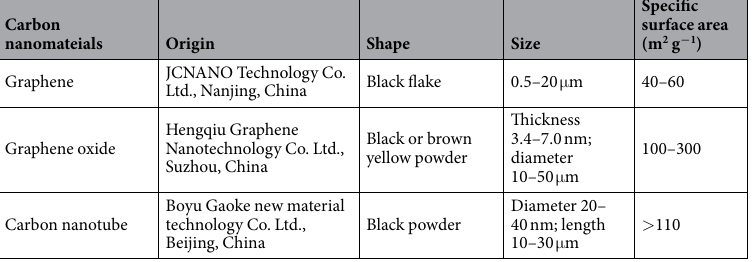
Table 3. The properties and origins of the carbon nanomaterials used in this